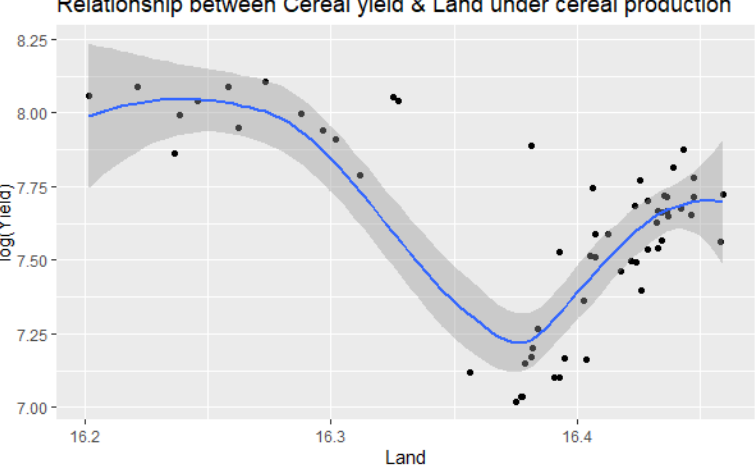
Figure 2. Relationship between 𝐿𝑎𝑛𝑑 and log (𝑌𝑖𝑒𝑙𝑑) with a smooth curve. From the information given above, the semiparametric time-series model is written as follows: